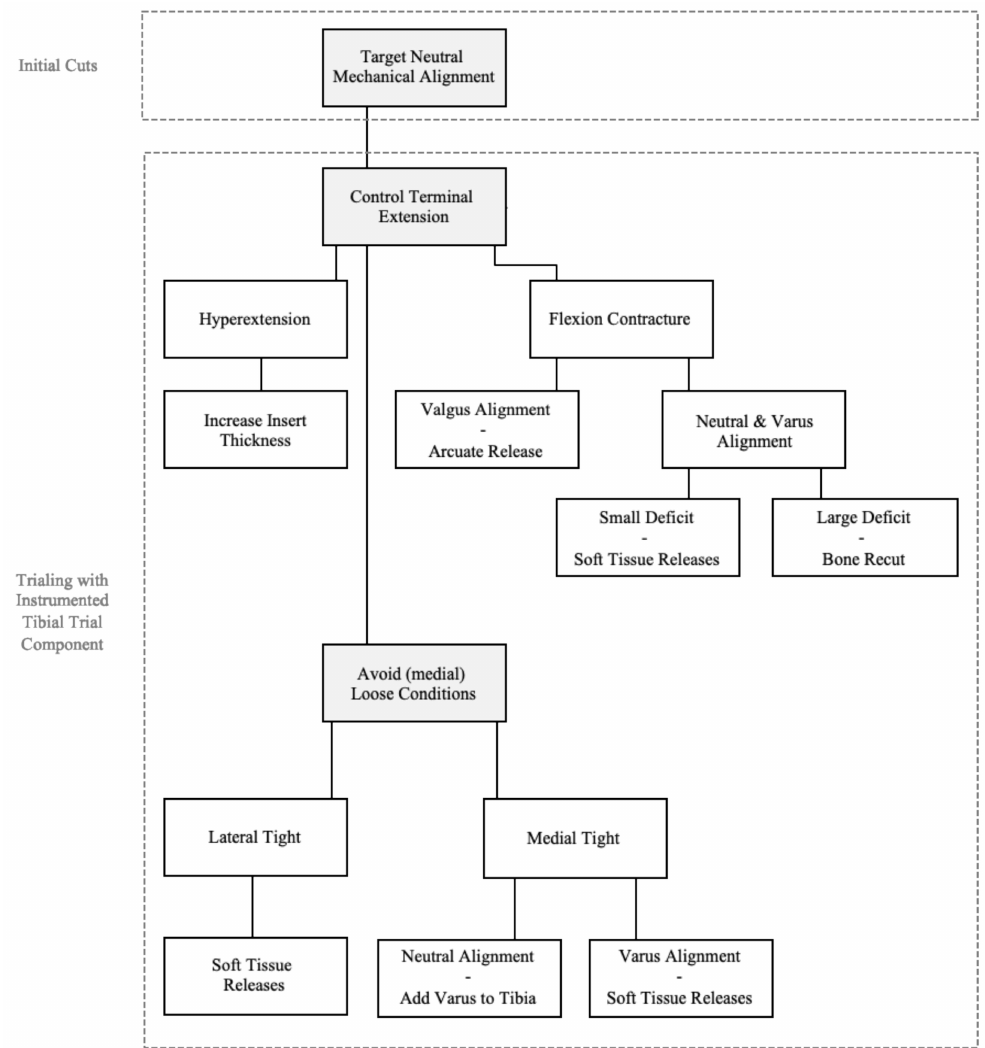
Figure 6. Surgical decision process to assure satisfactory alignment and soft tissue balance while balancing a total knee during the trialing